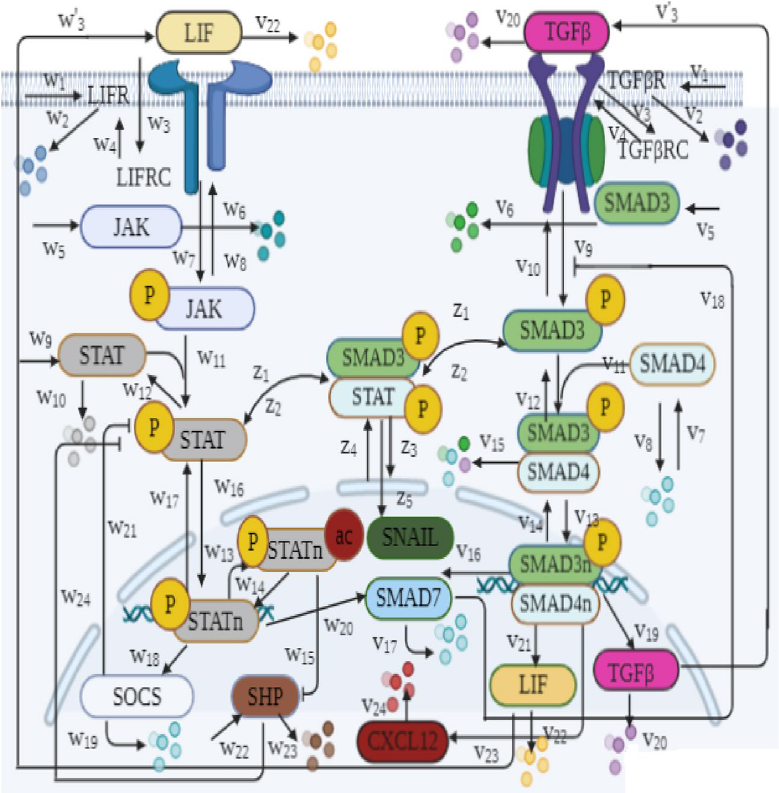
Figure 3. Biochemical reactions involved in dynamic model of TGFβ and LIF pathways as well as their crosstalk within the CAFs. The name of each reaction has been shown on the corresponding arrow. More information about the mathematical representation of reactions are included in Tables 2, S2, and